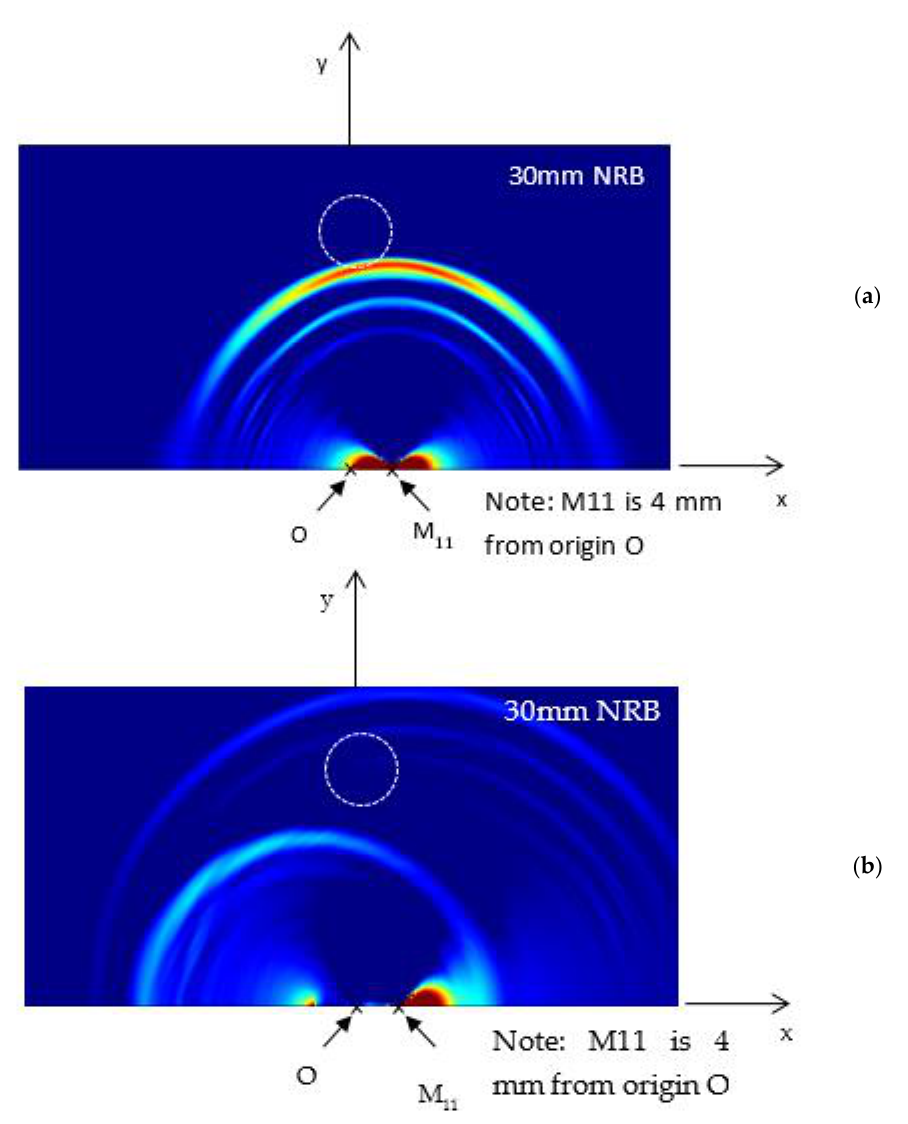
Figure 4. Wave propagation pattern of surface strain ( ε xx + ε yy ) due to ( a ) no crack and ( b ) 8 mm